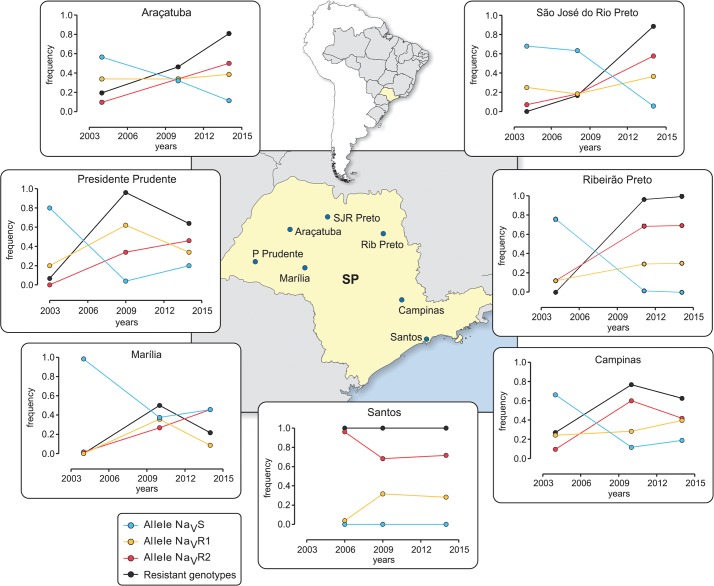
Frequencies of susceptible (NaVS) or kdr (NaVR1 and NaVR2) alleles and resistance genotypes (R1R1, R1/R2 and R2R2) in Aedes aegypti populations from São Paulo State (SP) between 2003 and 2014.The composition of each allele considered both 1016 and 1534 NaV sites for each genotyped individual: NaVS (1016 Val+ + 1534 Phe+), NaVR1 (1016 Val+ + 1534 Cyskdr) and NaVR2 (1016 Ilekdr + 1534 Cyskdr). The municipalities are placed inside the highlighted map of SP State.